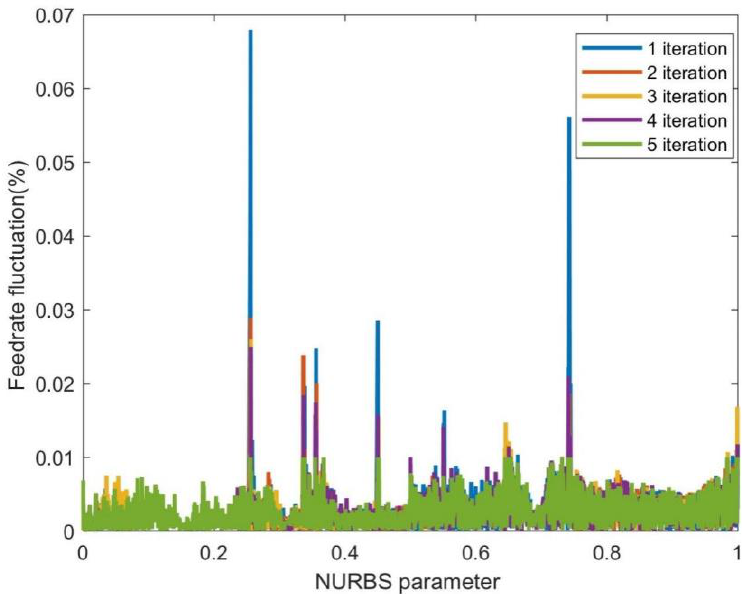
Figure 10. The feedrate fluctuation of the SAM with the two-level parameter compensation.